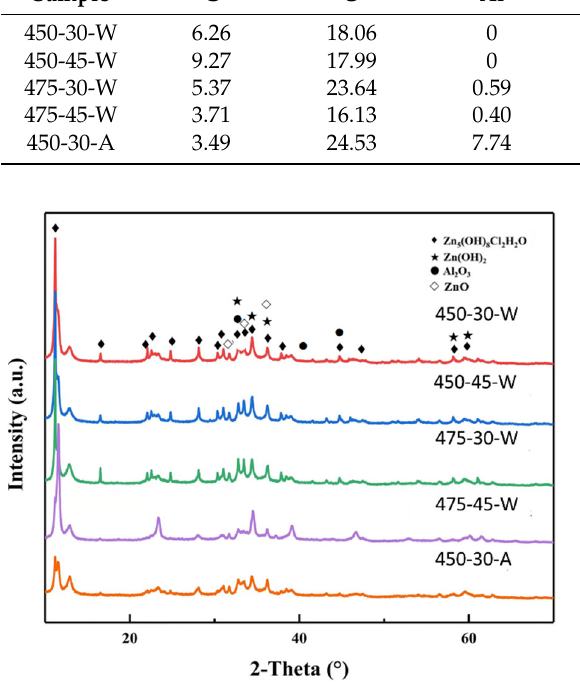
Figure 10. XRD results of corrosion products of hot dip plating layers with different process param- eters.